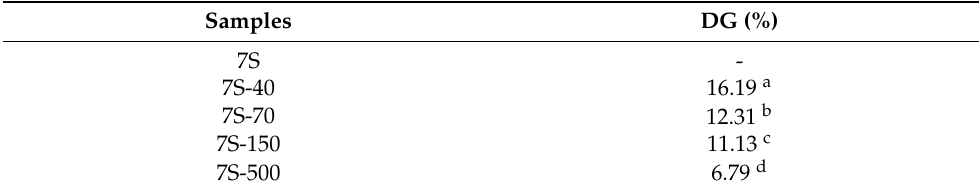
Table 1. Degree of glycation (DG%) of 7S and 7S-DEX conjugates (7S-40, 7S-70, 7S-150, 7S-500).